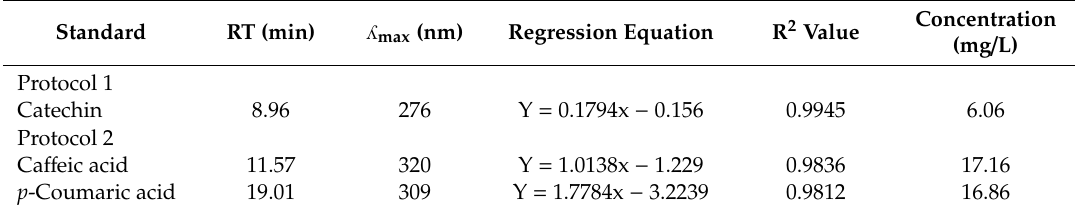
Table 4. Chromatographic parameters of the phenolic compounds analyzed by